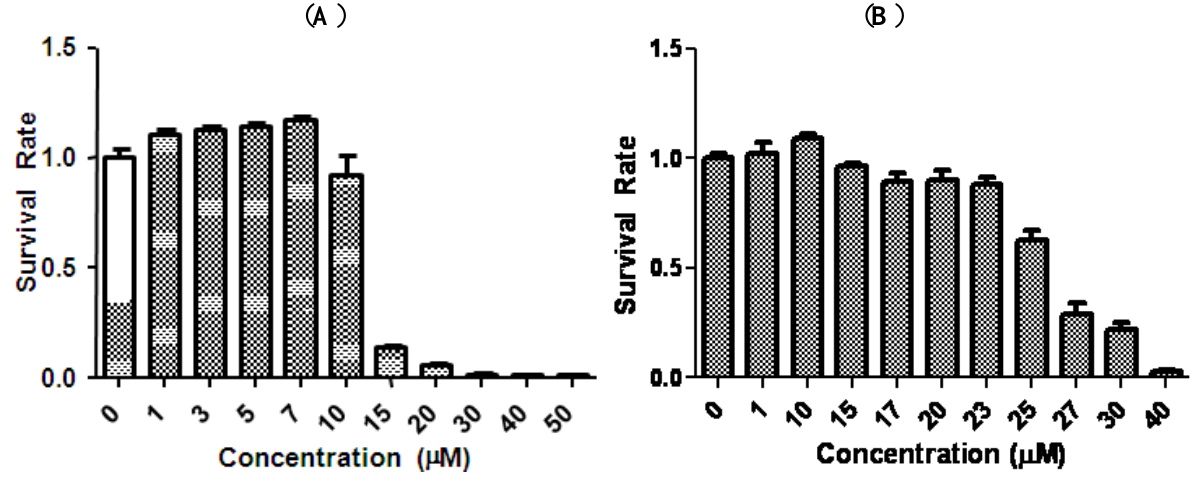
Figure 1. Tetrandrine inhibited proliferation in breast cancer cells. SUM-149 and SUM-159 were treated with increasing concentrations of tetrandrine for 96 h. The anti-proliferation effect of tetrandrine was measured by MTS assay. Error bars represent standard deviation. The data shown are representatives of three independent